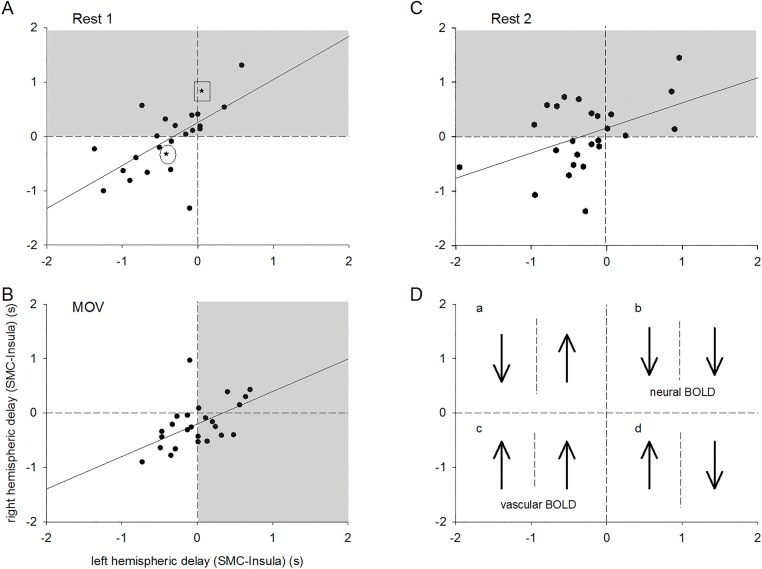
Interhemispheric asymmetry plots of PL delay between SMC and insula for rest 1 (A), movement (B) and rest 2 (C). Gray regions indicate the hemisphere with a majority of neural BOLD signals (pTD). In panel A two representative individuals are marked (rest 1), one (17R1a) with bilateral pTD (indicated by a square) and another (13R1a) with bilateral nTD (indicated by a circle). D: Cartoon illustrates the BOLD direction in the four quadrants (quadrant b: bilateral pTD; quadrant c: bilateral nTD).